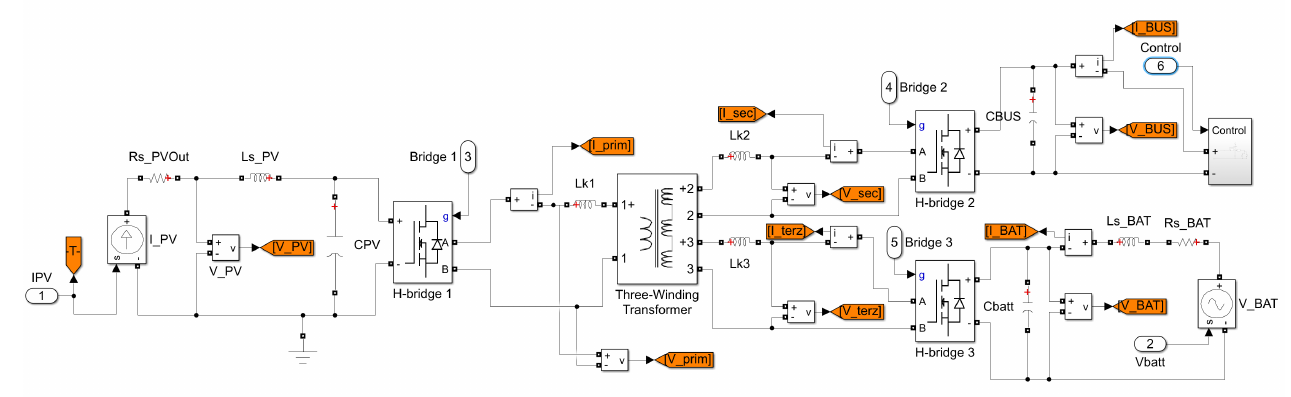
Figure 13. Simulink electrical model.